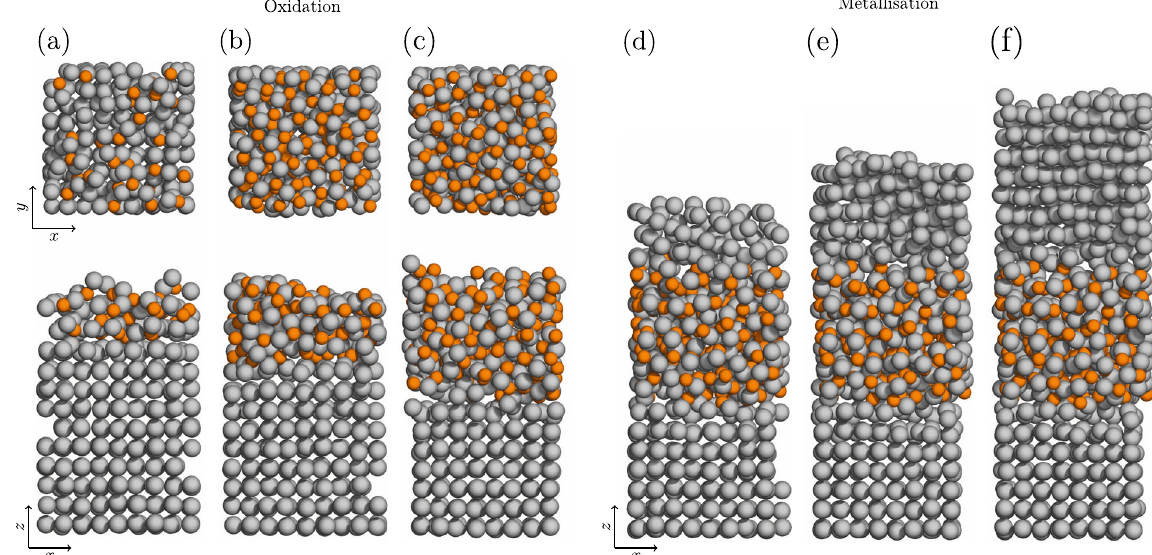
Fig. 1 Overview of the junction formation simulation. An amorphous oxide is formed on an Al(100) surface as oxygen atoms are iteratively added to the simulation cell. Oxygen and aluminium atoms are shown as orange and grey spheres, respectively. a – c Views along and perpendicular to the z -axis after 30, 90, and 150 oxygen atoms have been introduced. d – f The growth of the second aluminium contact during the metallisation simulation. This calculation was performed with the S – M potential.